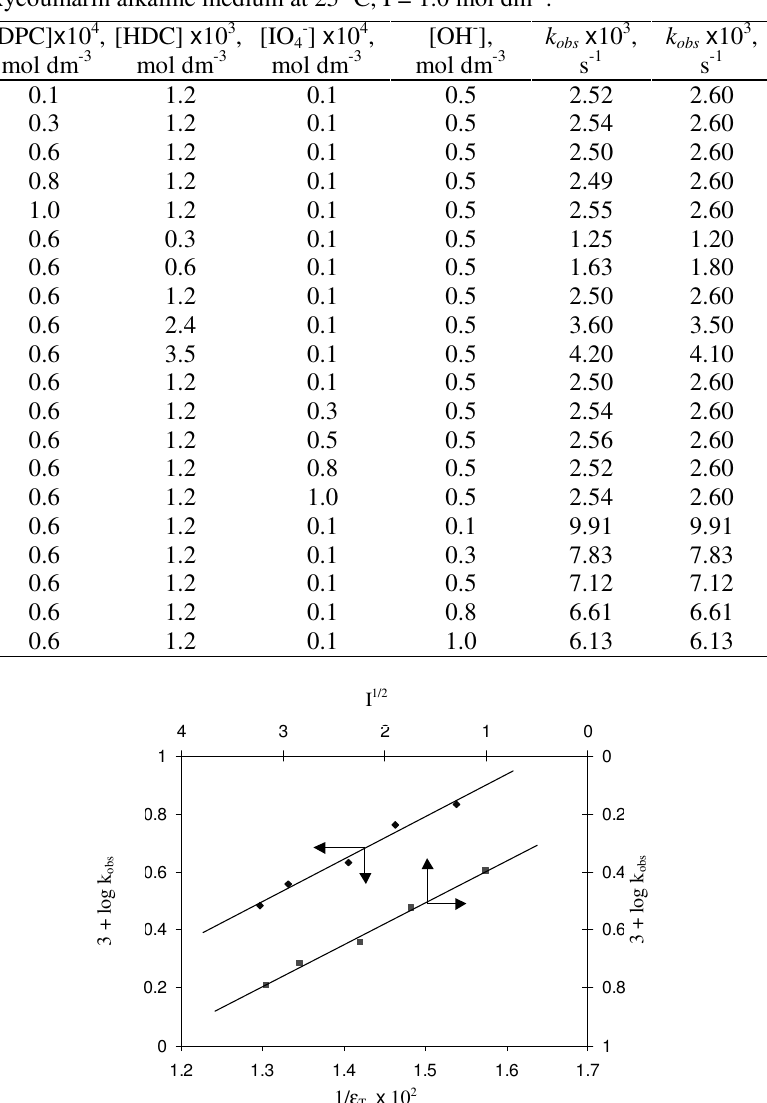
Table 1. Effect of [DPN], [HDC], [IO 4- ] and [OH - ] on diperiodatonickelate(IV) oxidation of